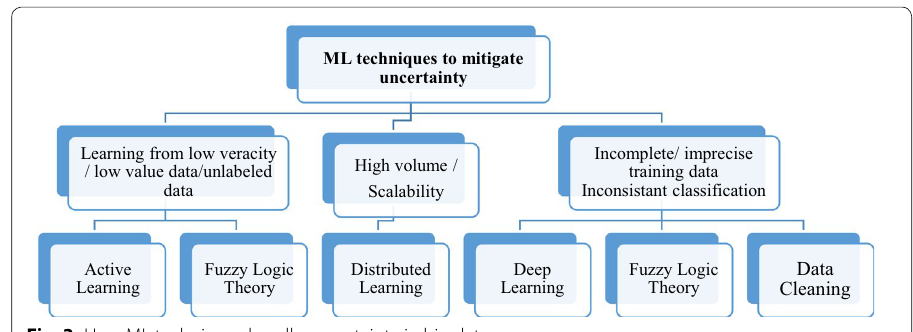
Fig. 3 How ML techniques handle uncertainty in big